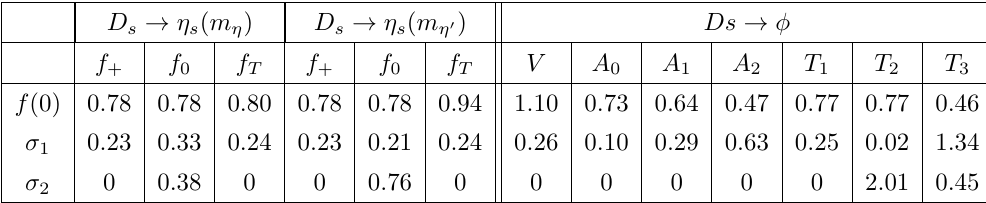
Table 16 . Part I: Best-(cid:12)t parameters for D s decays from ref. [129].